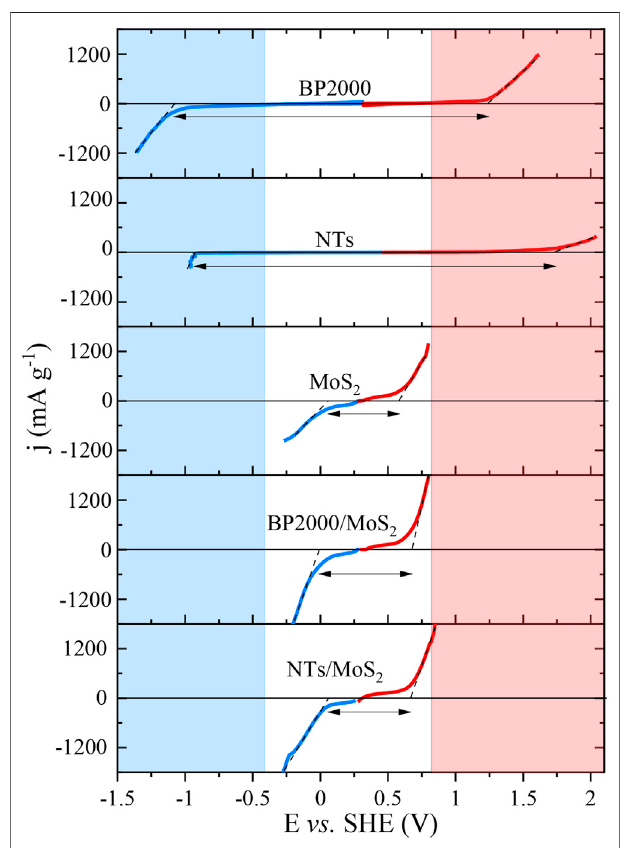
FIGURE10| Linear sweepvoltammetry plotsfordifferentsamples(pure materials and carbon/MoS 2 composites) at 2 mVs − 1 .